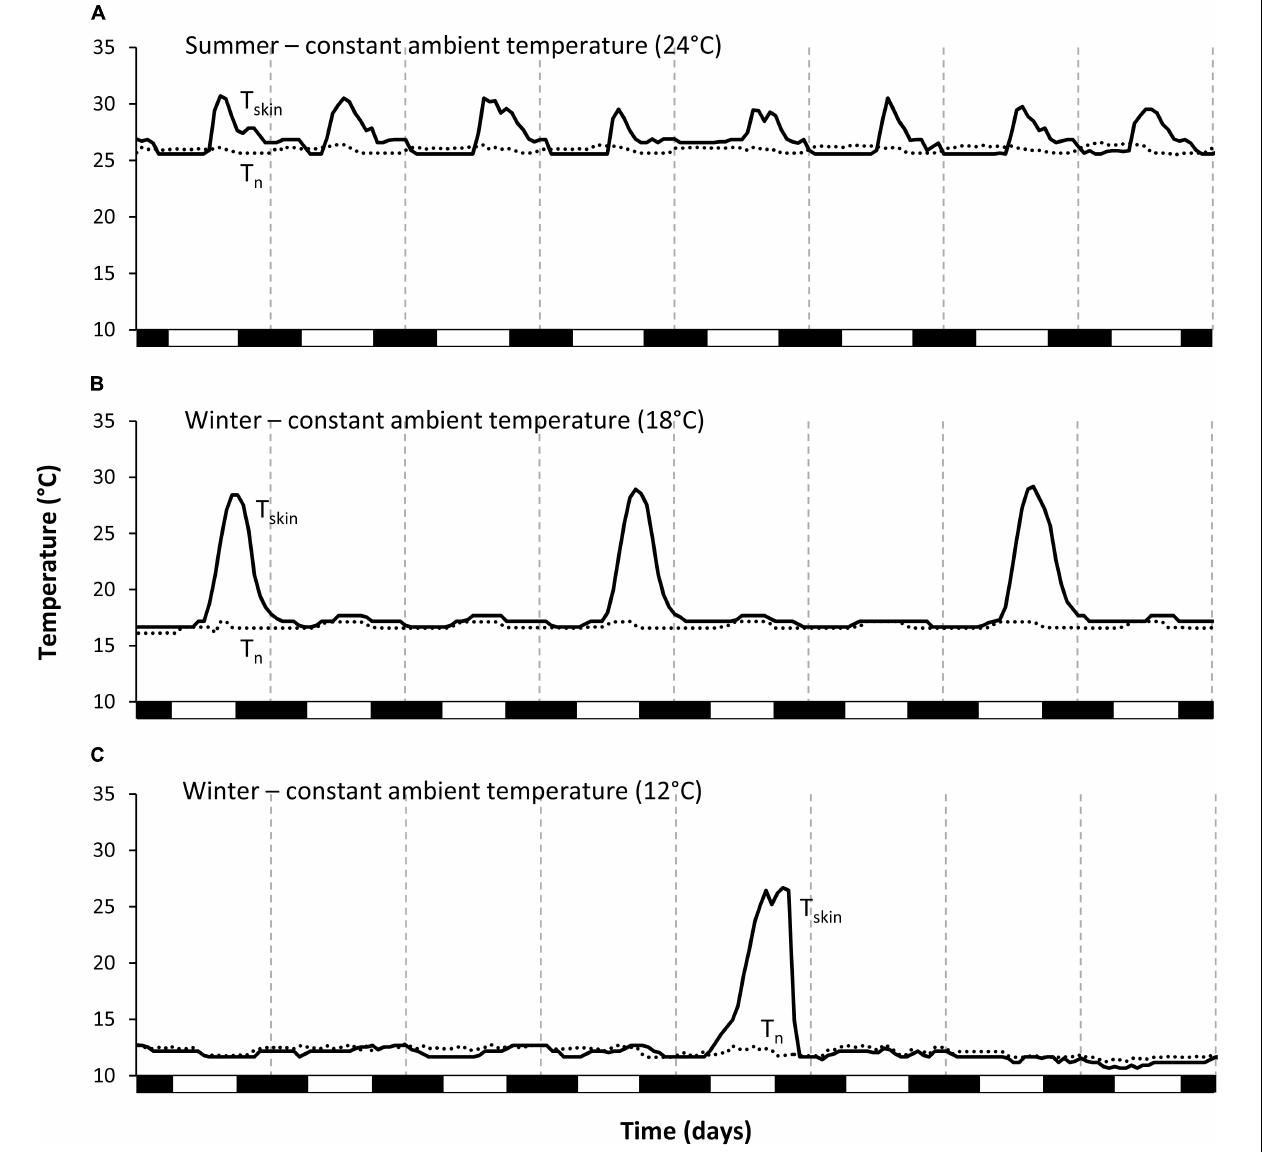
FIGURE 2 | Examples of typical sequences of skin temperature of one individual Echinops telfairi during the different constant treatments over eight days. (A) Summer 24 ◦ C, (B) winter 18 ◦ C, and (C) winter 12 ◦ C. During summer, tenrecs aroused daily to normothermic skin temperature; during winter, torpor bouts became longer, even more so at the lower ambient temperature. Black line: skin temperature; dotted line: nest box temperature; vertical dashed lines indicate midnight, black boxes on the x -axis the